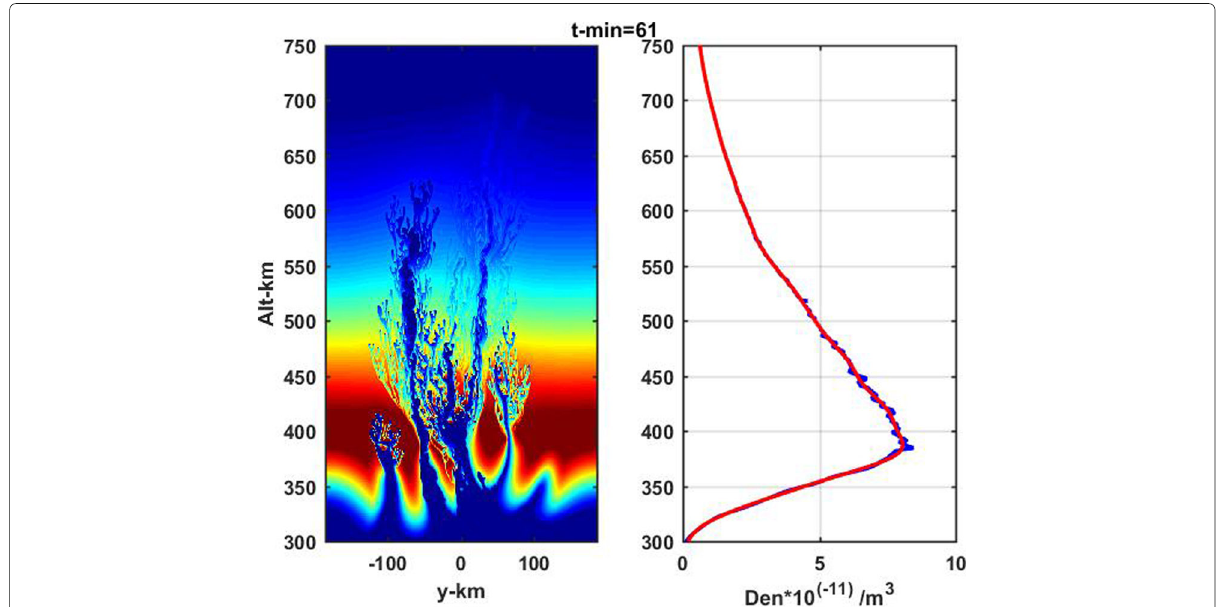
Fig. 4 The left frame shows the offset1 plane structure at 1 h. The right frame shows the path-integrated density (blue) with a smoothed profile overlaid (red)